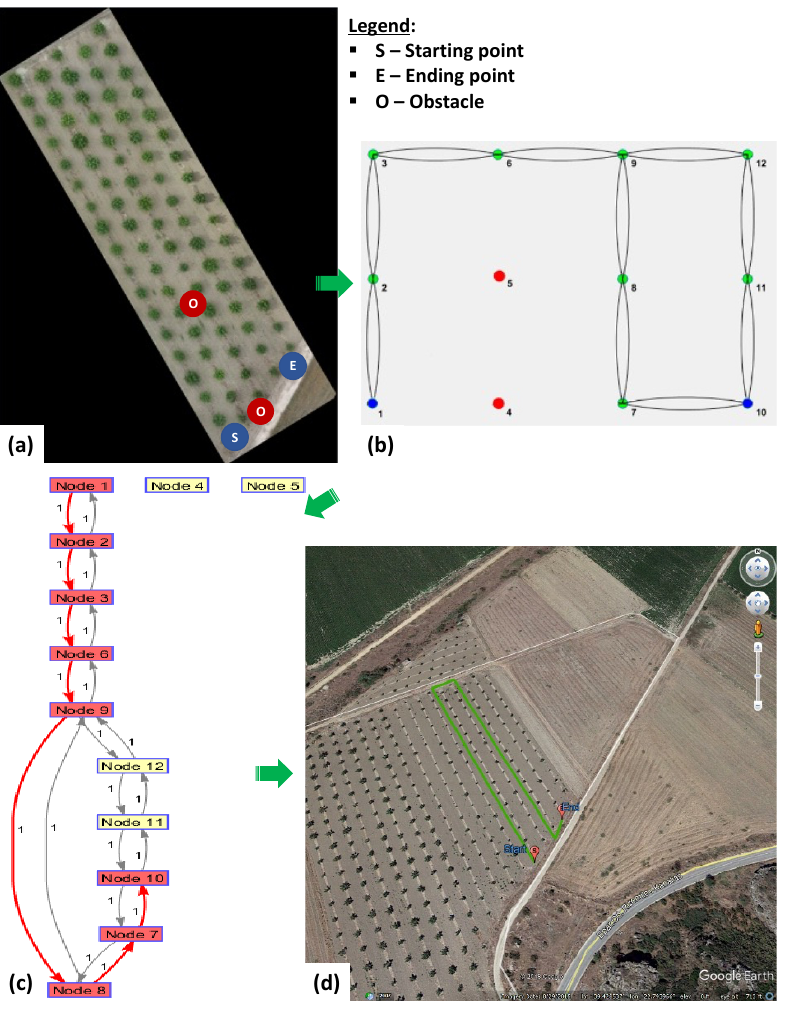
Figure 15. Route planning, Scenario #2: ( a ) initial map; ( b ) topological grid; ( c ) graph; and ( d ) optimal path plan.